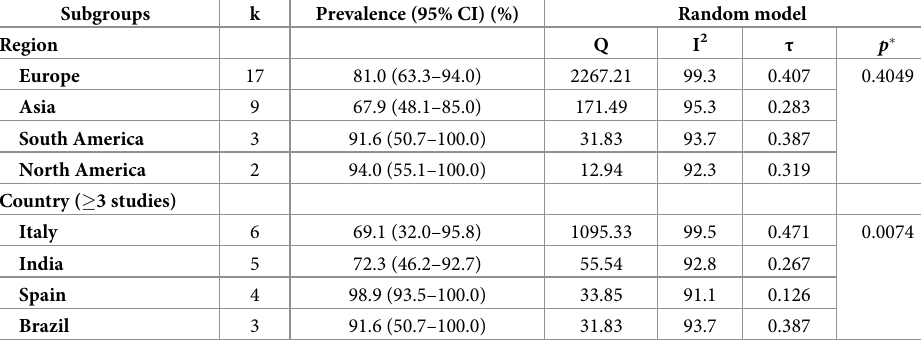
Table 4. Subgroup analysis for different geographical regions and